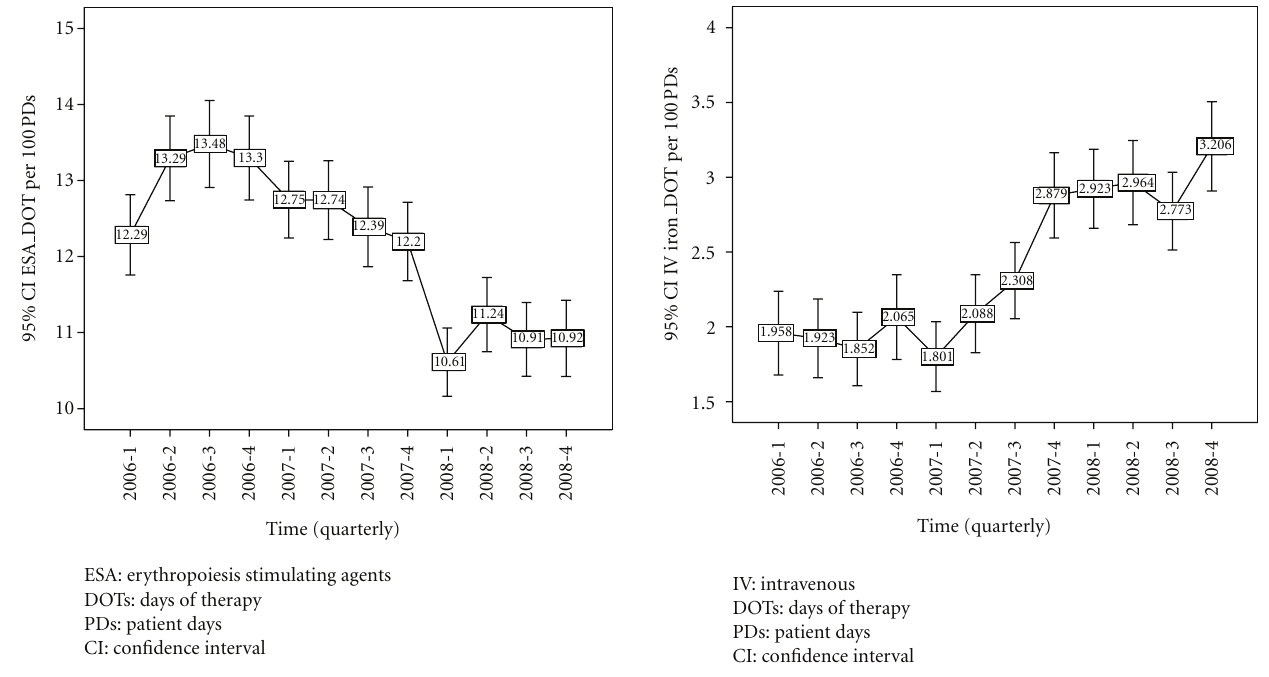
Figure 2: Mean ESA DOTs/100 PDs use (with 95% CI) from 2006– 2008 (by each quarter).